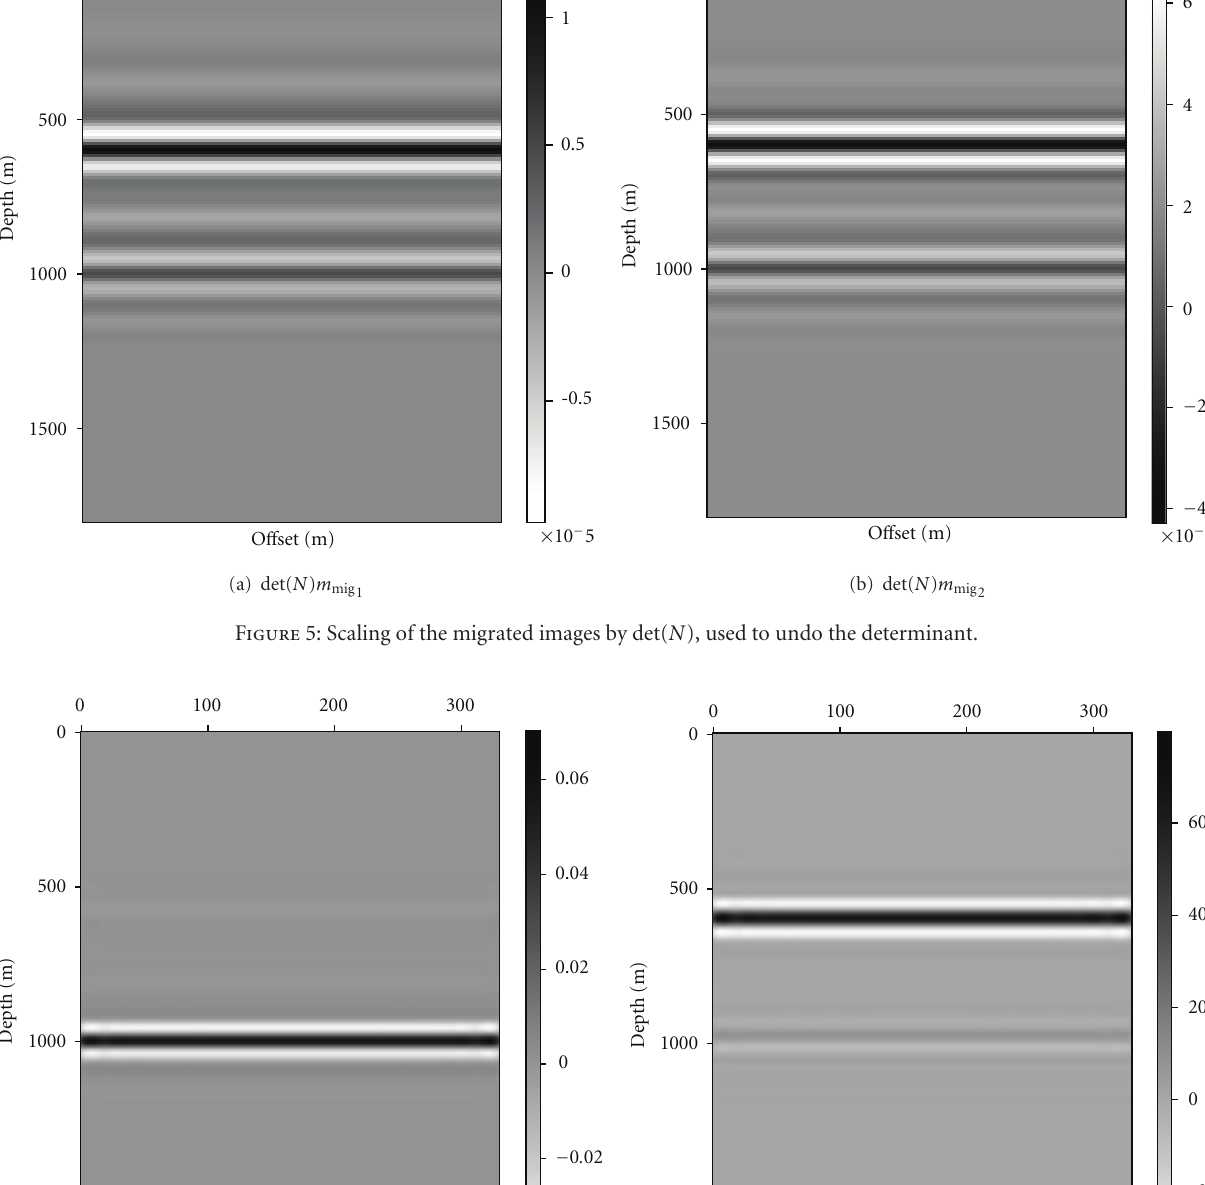
with angle and must therefore be included in the parameters to be